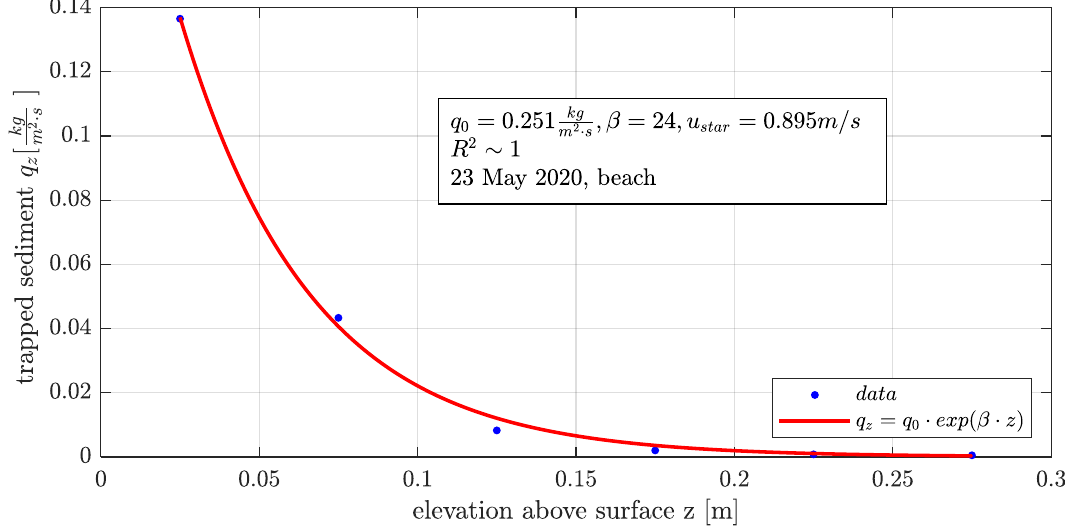
Figure 10. Representative example of the vertical distribution of sediment transport flux on the beach derived from the vertical mesh sand trap for the measurement location of the beach and the best fit exponential decay function.